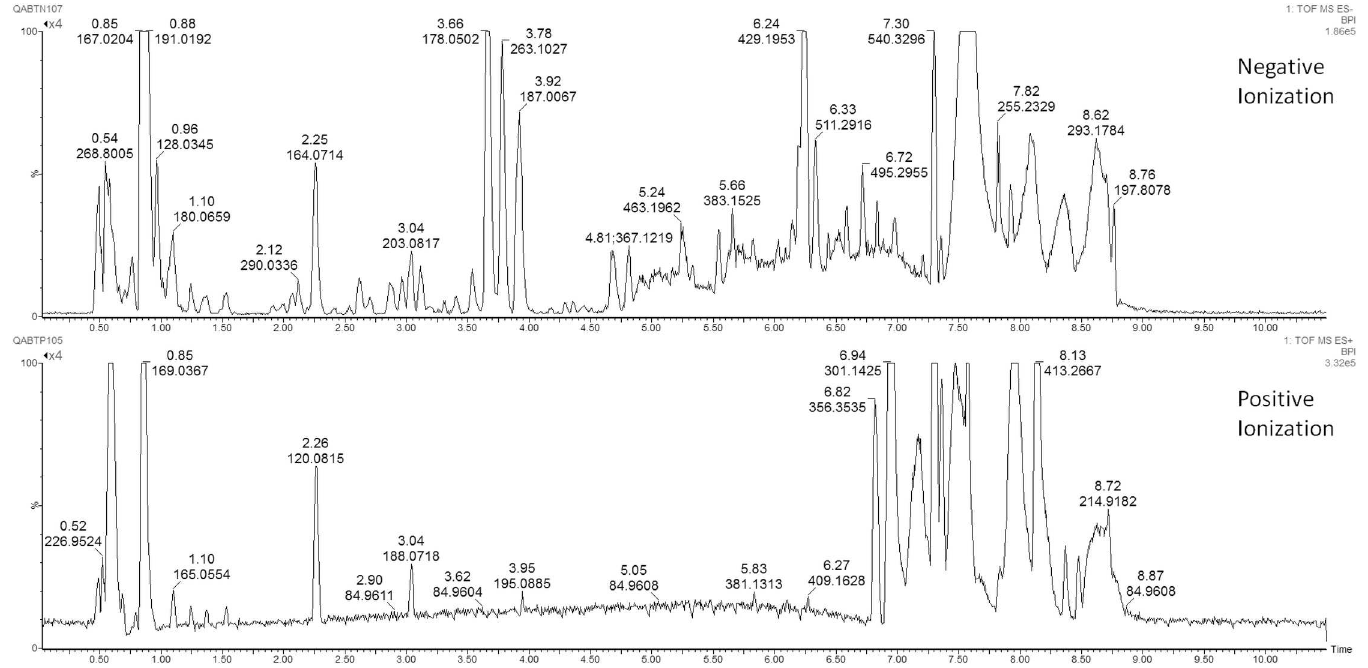
Fig 1. Chromatographic profiles of an amniotic fluid sample, derived from the reverse-phase column HSS T3, with both positive and negative ionization